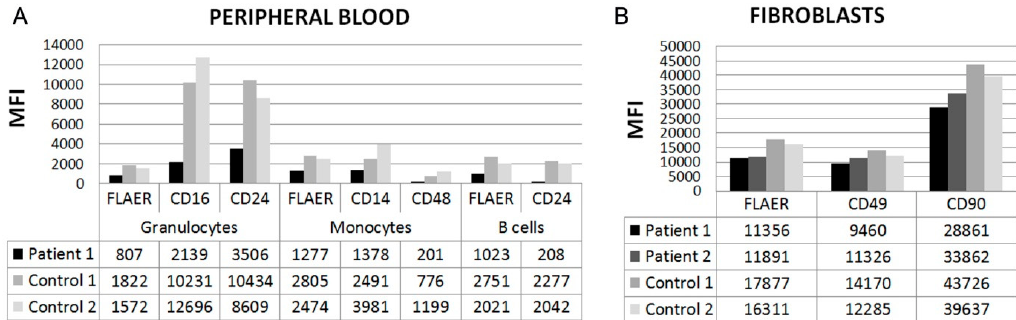
Figure 2. ( A ) Abundance of glycosylphosphatidylinositol (GPI)-anchored proteins measured by flow cytometry in two controls, in patient 1 in peripheral blood, and in patient 1 and 2 in skin fibroblasts ( B ). Cells were stained with fluorochrome conjugated aerolysin (FLAER) to detect total GPI-anchors and with fluorochrome conjugated antibodies to detect GPI-anchored proteins (CD14, CD16, CD24, CD48, CD49, and CD90). The y -axis displays Median Fluorescent Intensities (MFI) of proteins on indicated cell populations.